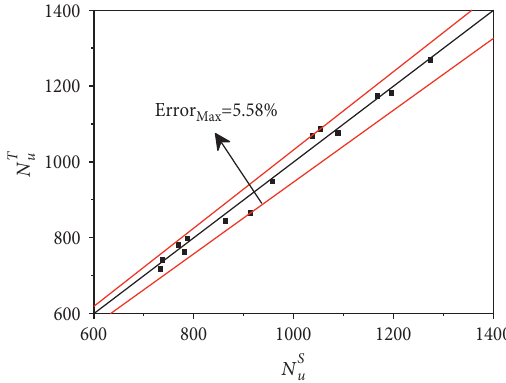
Figure 5: Comparison between N T